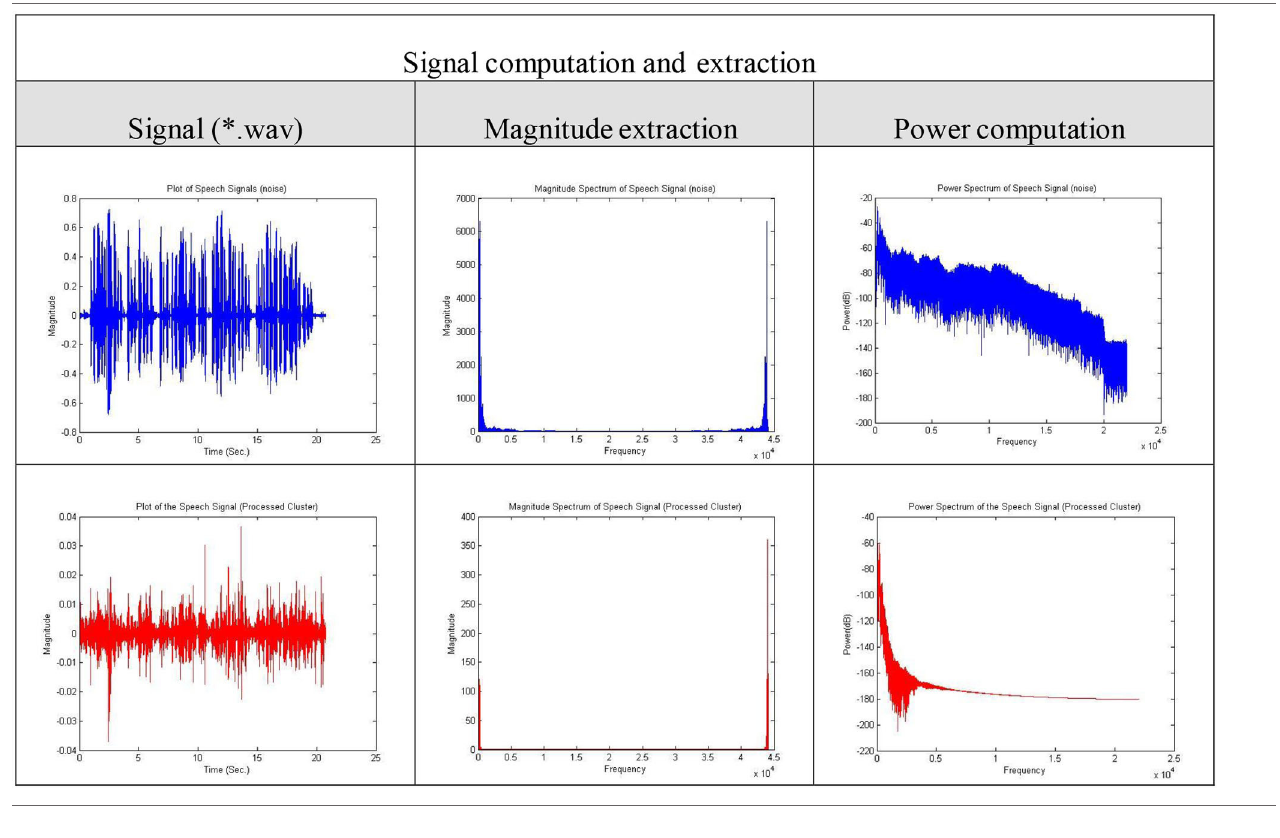
TABLE 3 | Signal processing and analysis